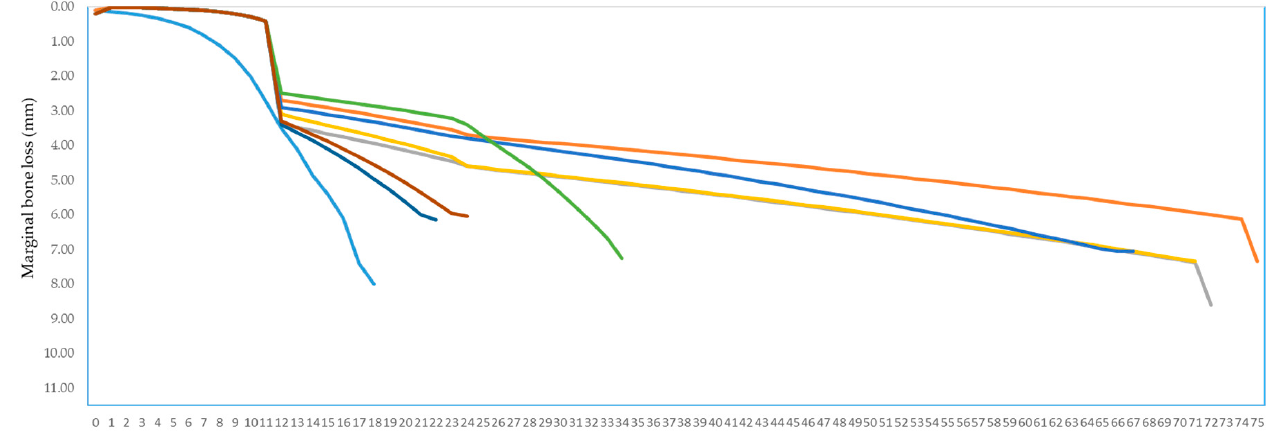
Figure 3. Marginal bone loss (MBL) of 8 failed implants shown in different colors. Most of the failed implants showed early bone loss. Table 6. MBL of implants in IC-RPDs and IODs based on multiple variables. Condition